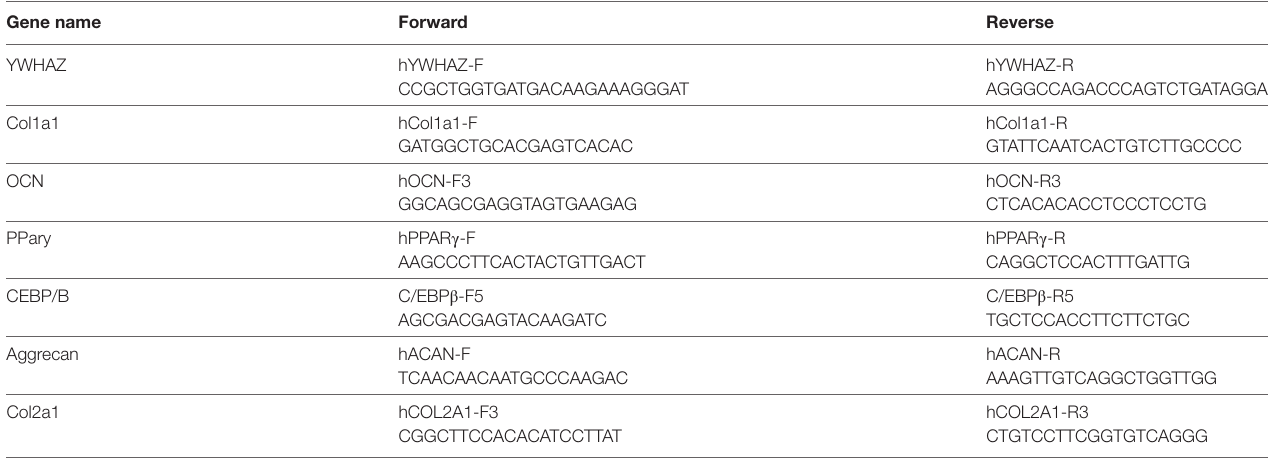
TaBle 2 | List of primers used for RNA analysis of differentiation